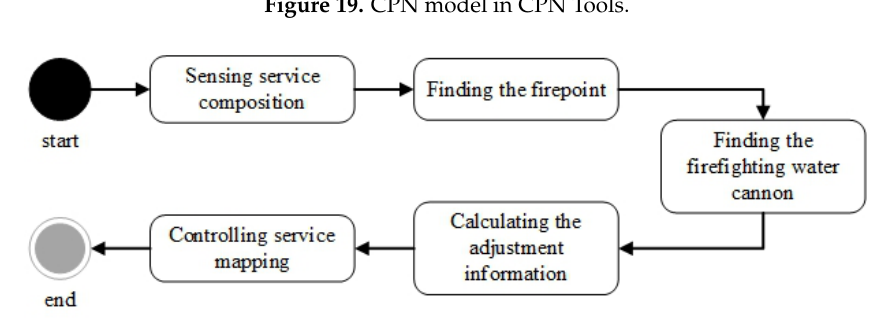
Figure 19. CPN model in CPN Tools.